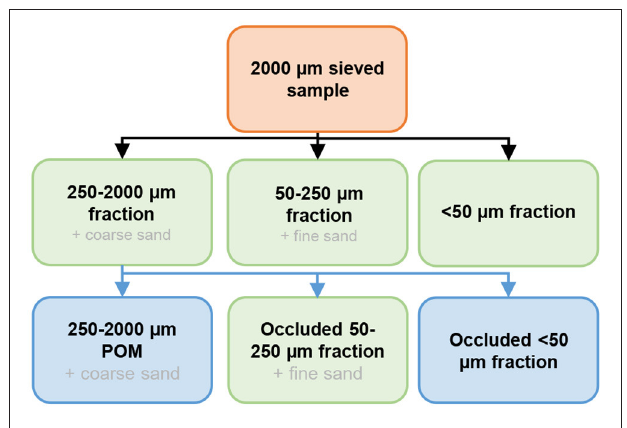
FIGURE 2 | Schematic representation of the soil aggregate-size fraction separation method. Green rectangles represent the pools in which OC concentrations were measured. Black arrows represent the wet sieving method and blue arrows represent 250–2,000 µ m fraction separation.